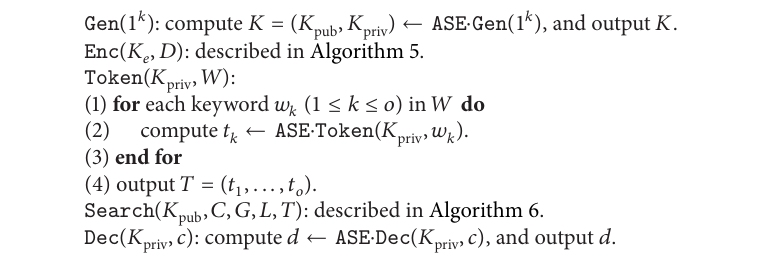
Algorithm 7: LSE scheme: asymmetric